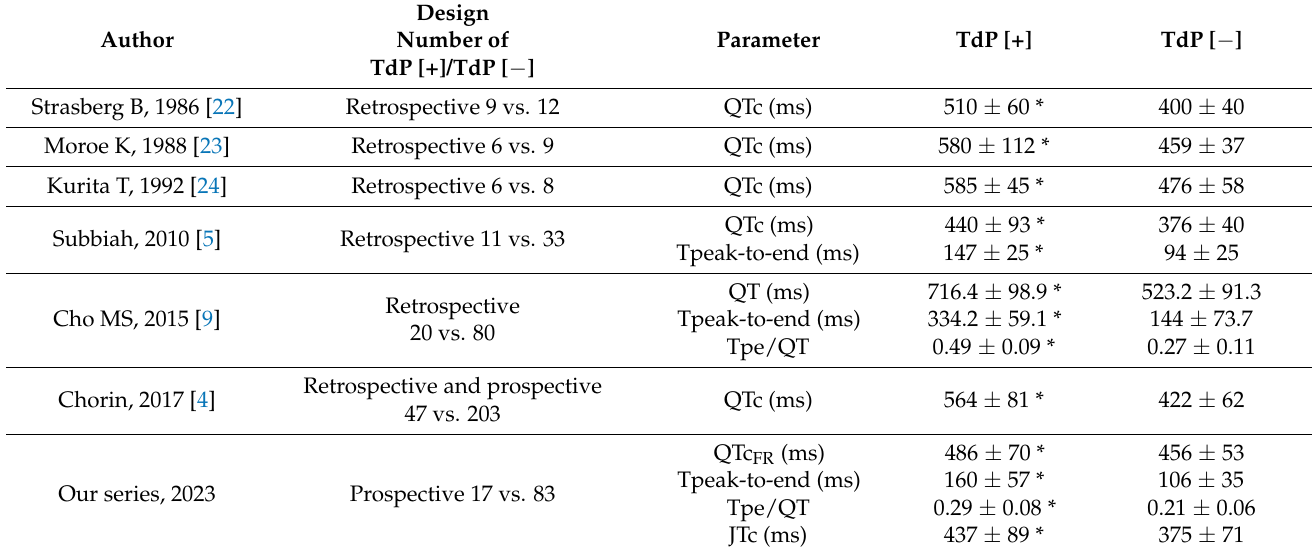
Table 3. Summary of published studies of ECG parameters in TdP patients during